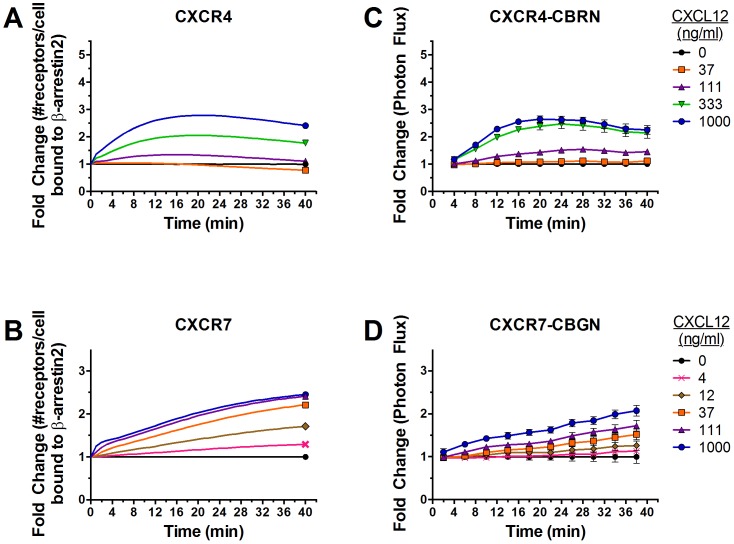
CXCR7 limits interaction of CXCR4 and β-arrestin 2 in CXCR4+-CXCR7+ cells.(A and B) Model outputs for CXCL12-dependent recruitment of β-arrestin 2 specifically to CXCR4 (A) or CXCR7 (B) in CXCR4+-CXCR7+ MDA-MB-231 cells. (C and D) Experimental data for recruitment of β-arrestin 2-CBC to CXCR4-CBRN (C) or CXCR7-CBGN (D) in CXCR4+-CXCR7+ cells. Legend shows concentrations of CXCL12-α used for models and experimental data. Data were graphed as mean values ± SEM for fold change in bioluminescence relative to untreated cells as in Figure 1 (n = 4 per experimental point).